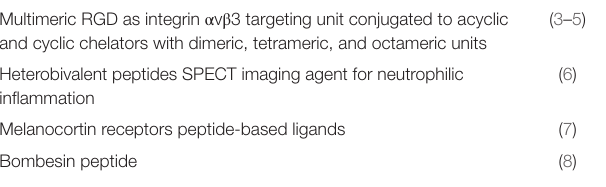
TABLe 1 | Few reports on successful targeting using multimeric peptides.